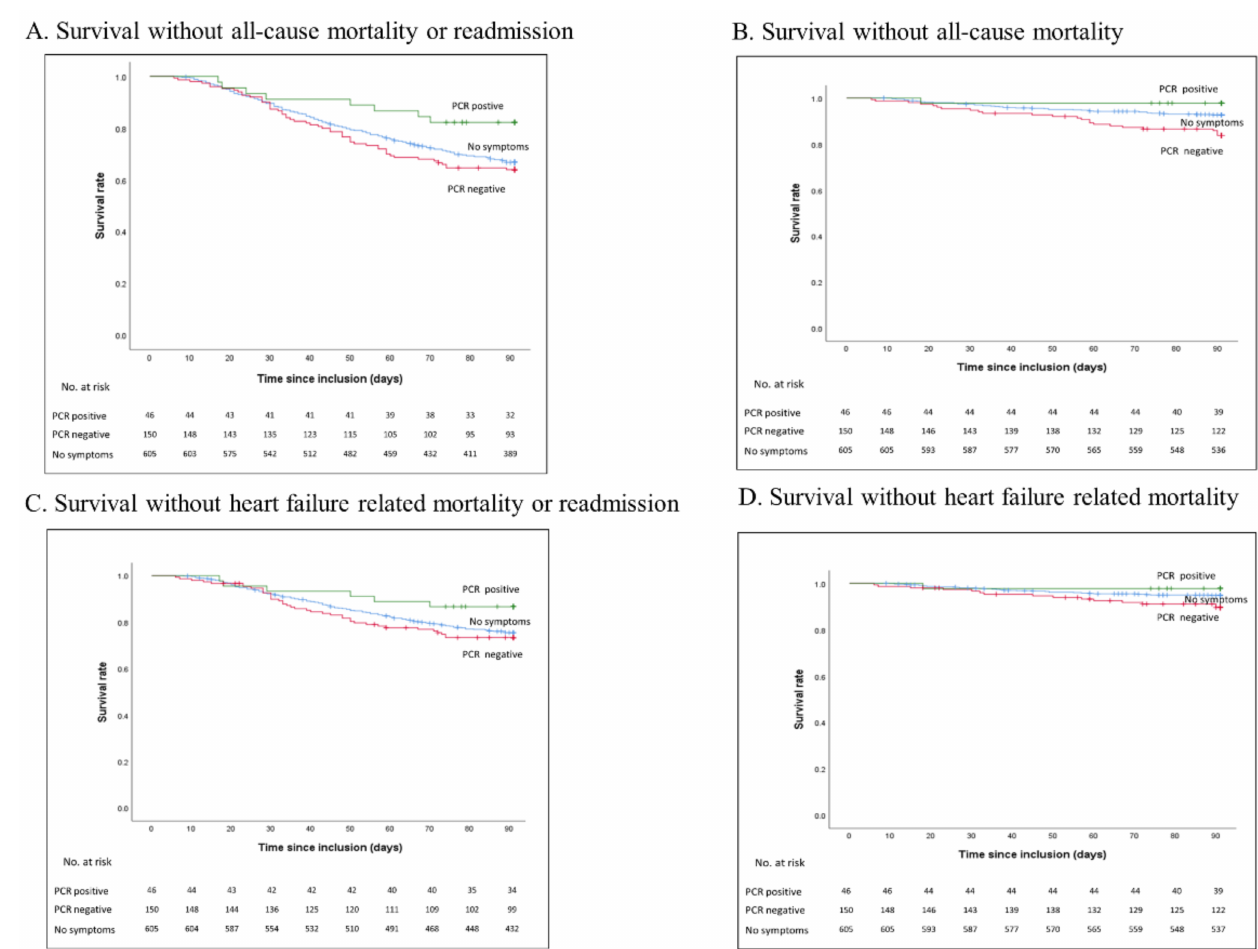
Figure 1. Kaplan-Meier survival analysis for 90-day clinical endpoints based on Influenza and respiratory syncytial virus (RSV) testing. Green: PCR positive, Red: PCR negative, Blue: patients without flu-like symptoms (no symptoms). ( A ). Survival without all-cause mortality or readmission, ( B ). Survival without all-cause mortality, ( C ). Survival without heart failure related mortality or readmission, ( D ). Survival without heart failure related